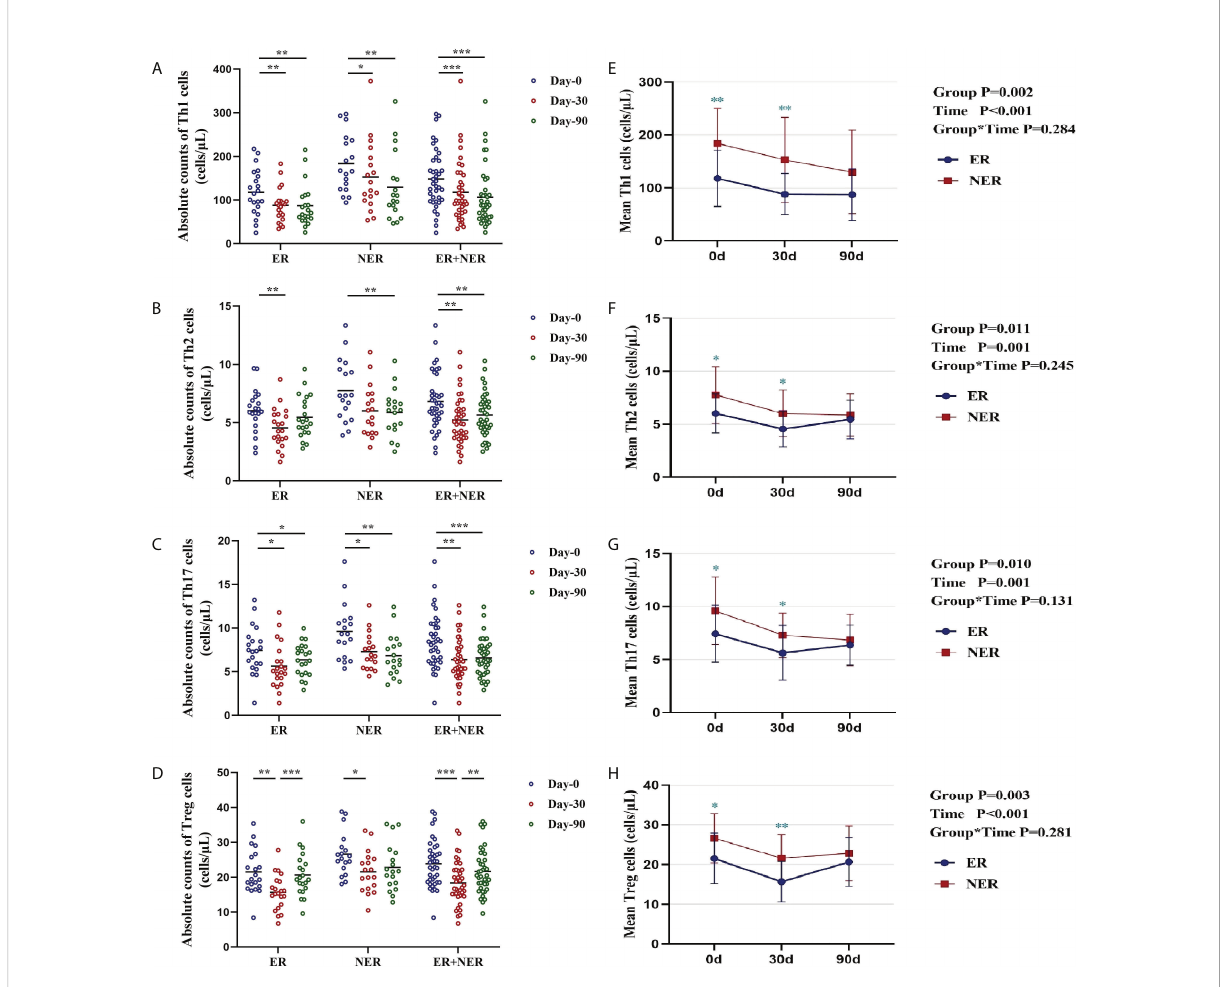
FIGURE 3 Dynamic changes and differences in absolute counts of circulating CD4 + T cell subsets in patients with ER, NER, and all DTC patients (ER+NER) before and after RAIT. (A – D) Dynamic changes in the absolute counts of circulating CD4 + T cell subsets before and after RAIT in each group. (E – H) Differences in the distribution and changes of absolute CD4 + T cell subsets counts before and after RAIT in the ER and NER groups . *p < 0.05, **p < 0.01, *** p < 0.001. ER, excellent response; NER, non-excellent response; RAIT, radioactive iodine